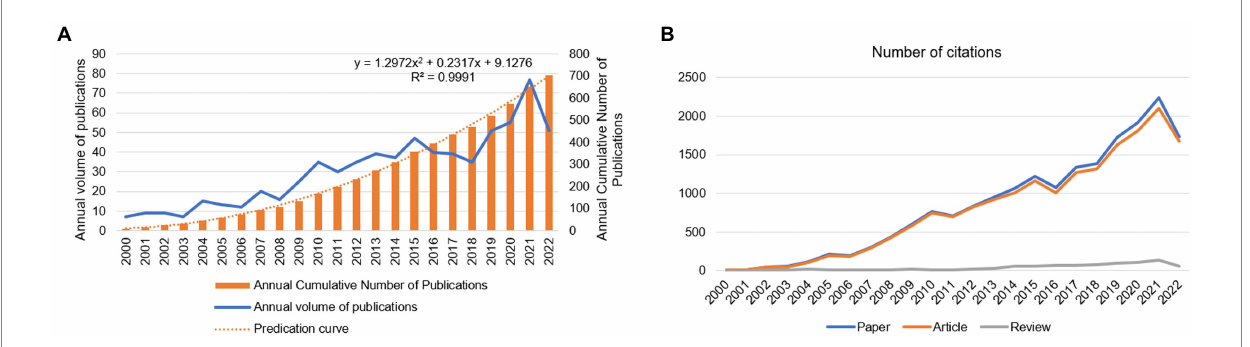
FIGURE 4 The number of publications and citations. (A) The number of publication outputs and growth trend from 2000 to 2022. (B) The number of annual citations from 2000 to